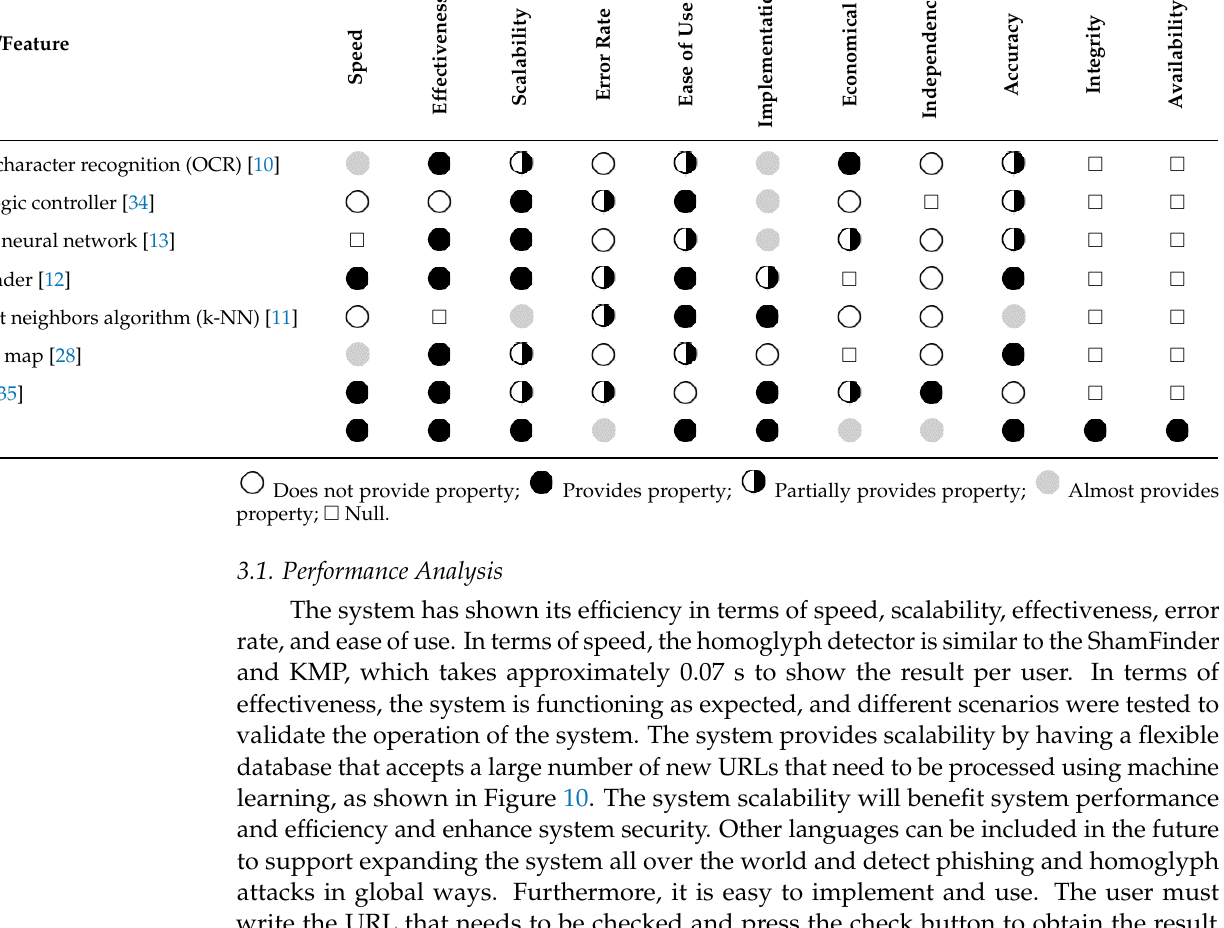
Table 4. Comparison with existing techniques.